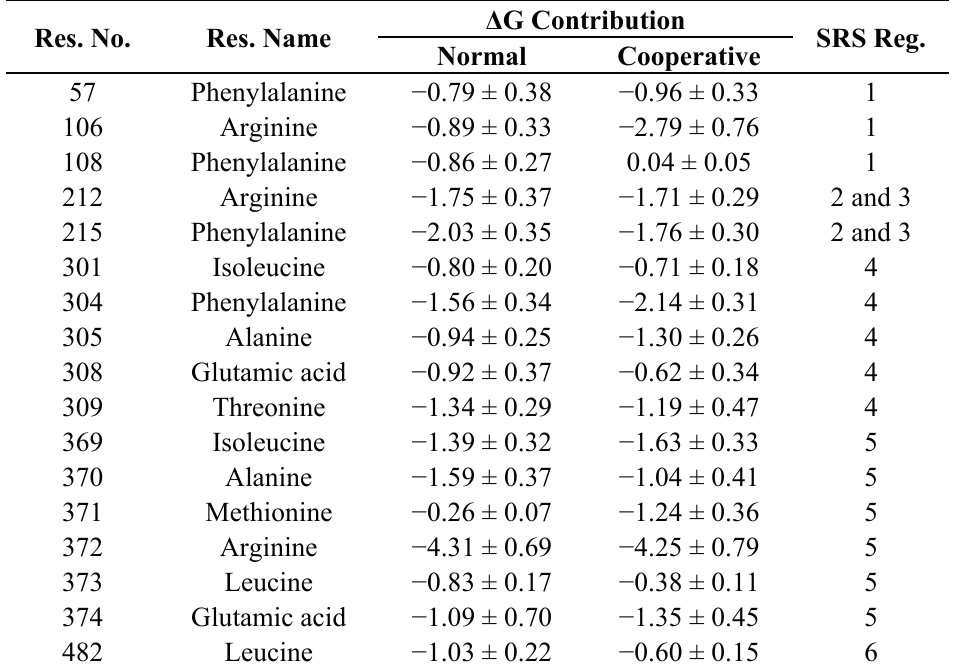
Table 2. Binding free energy decomposition for each residue located in the active pocket of the normal and cooperative binding models constructed based on the crystal structure 1tqn.pdb.